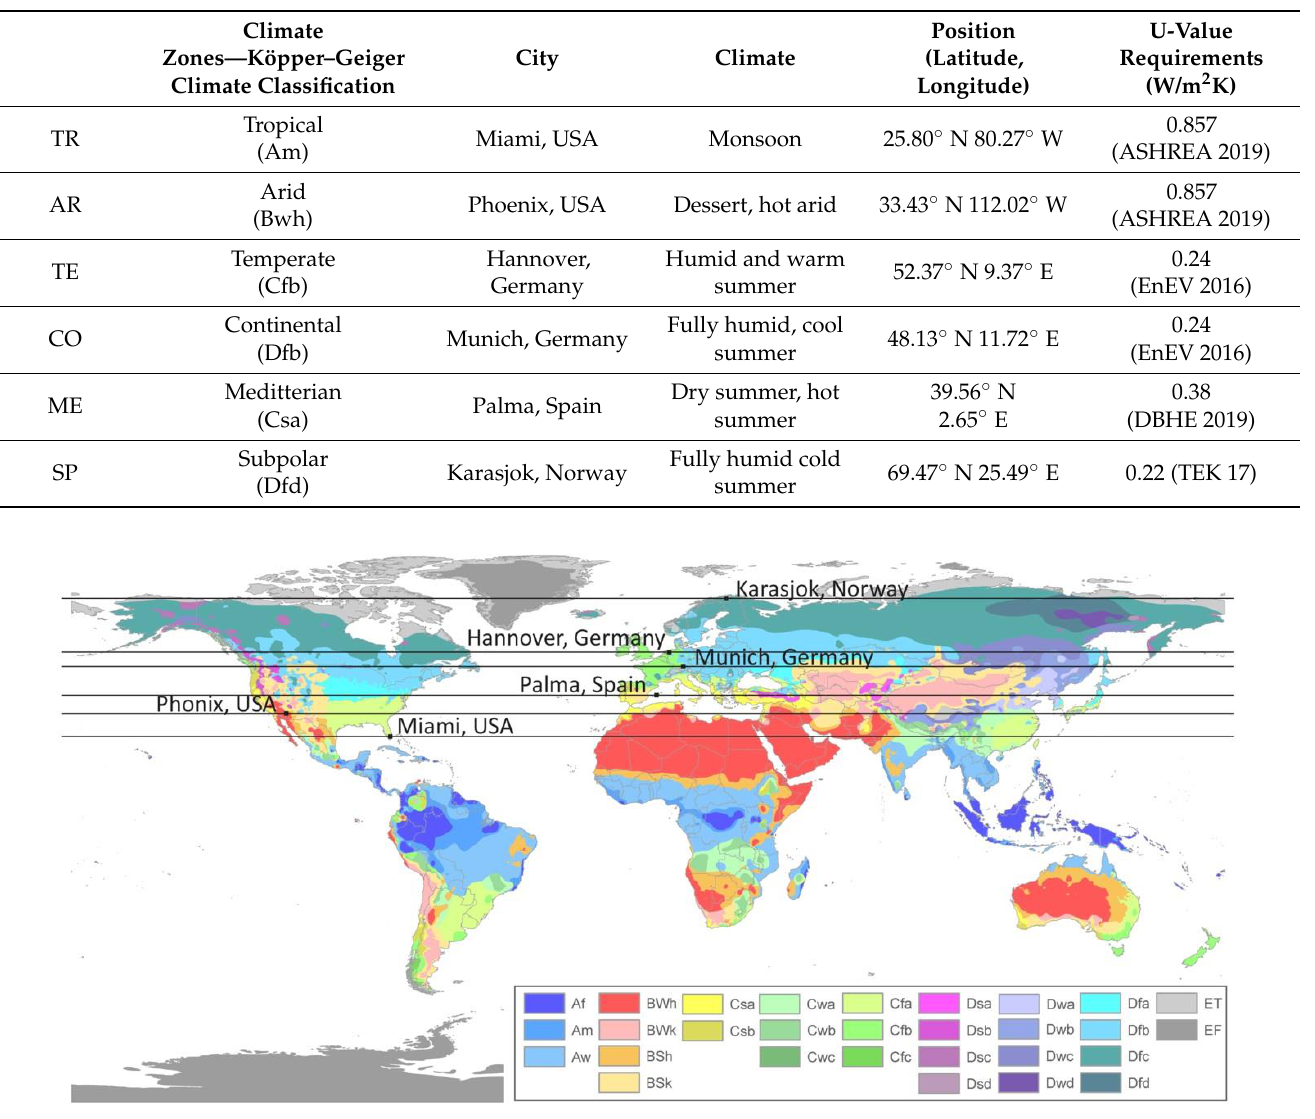
Figure 2. Six different climate zones in Europe and North America, according to the Köppen climate classification.